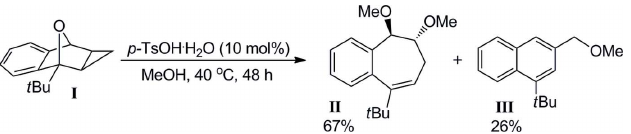
Figure 1 The reaction scheme.